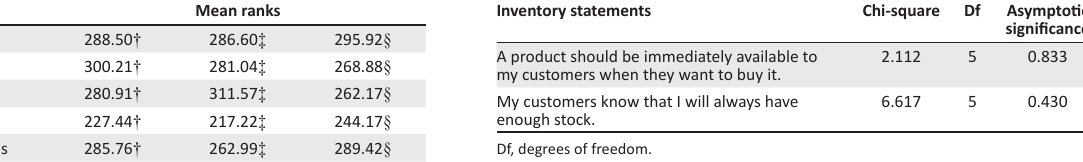
TABLE 13: Kruskal–Wallis test results on Hypothesis 3. TABLE 12: Mean ranks for Hypothesis 2.